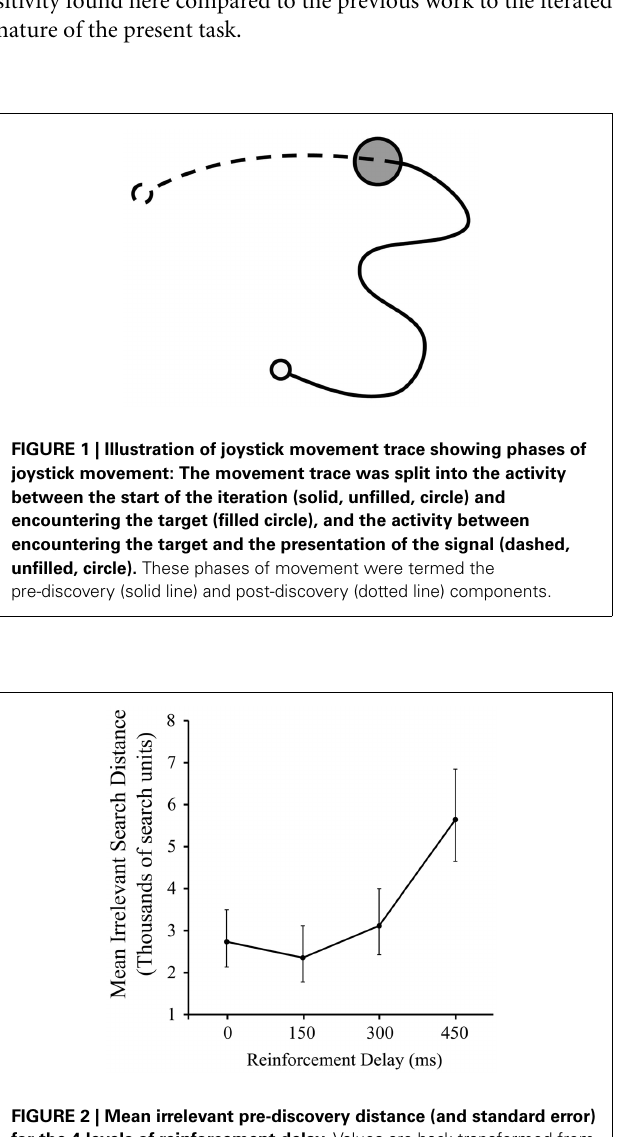
FIGURE 2 | Mean irrelevant pre-discovery distance (and standard error) for the 4 levels of reinforcement delay. Values are back-transformed from the log